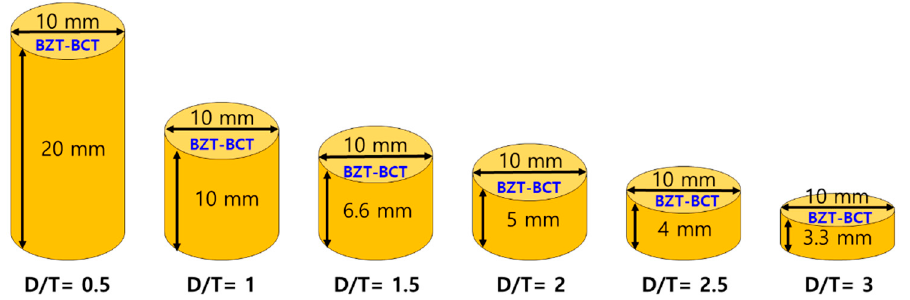
Figure 1. Schematic diagram of BZT–BCT ceramics with various D/T ratios (D/T = 0.5, 1, 1.5, 2, 2.5, 3).